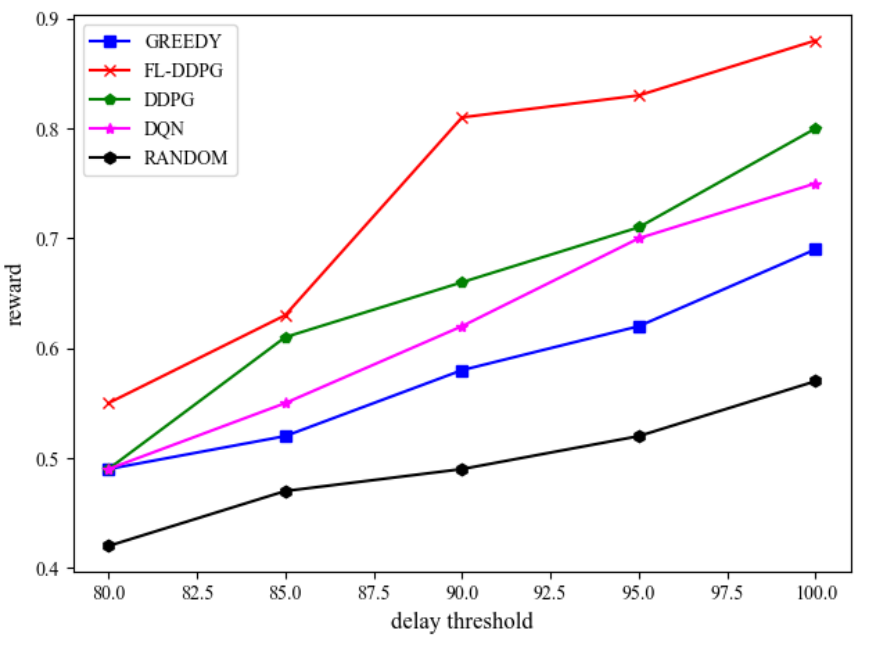
Figure 7. Performance evaluation on reward when the delay threshold is